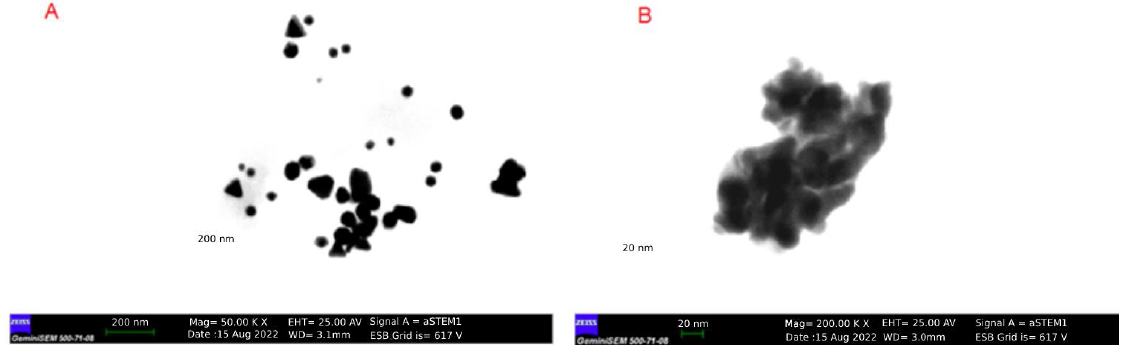
Figure 3. STEM image of H-AuNFs showing the particle shapes. ( A ) Dispersed H-AuNFs (bar scale: 200 nm); ( B ) magnified image (bar scale: 20 nm).